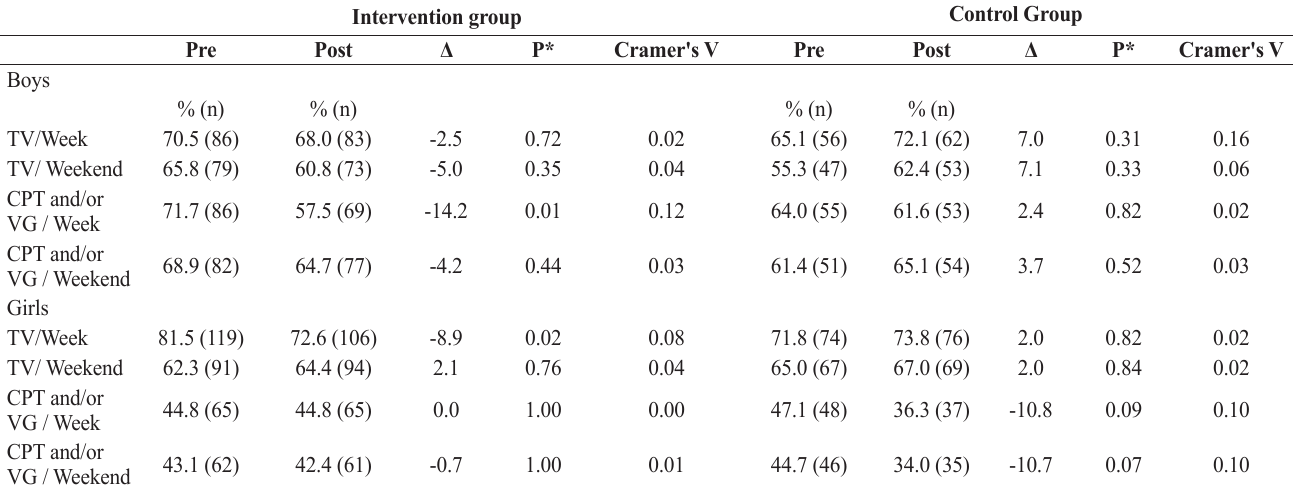
Table 2. Relative and absolute frequency of excess screen time (≥ 2 hours) for television, computer and / or videogame in the pre and post-intervention control and intervention groups, separated by sex. “MEXA-SE” Study, Florianópolis, SC / Brazil, 2015.